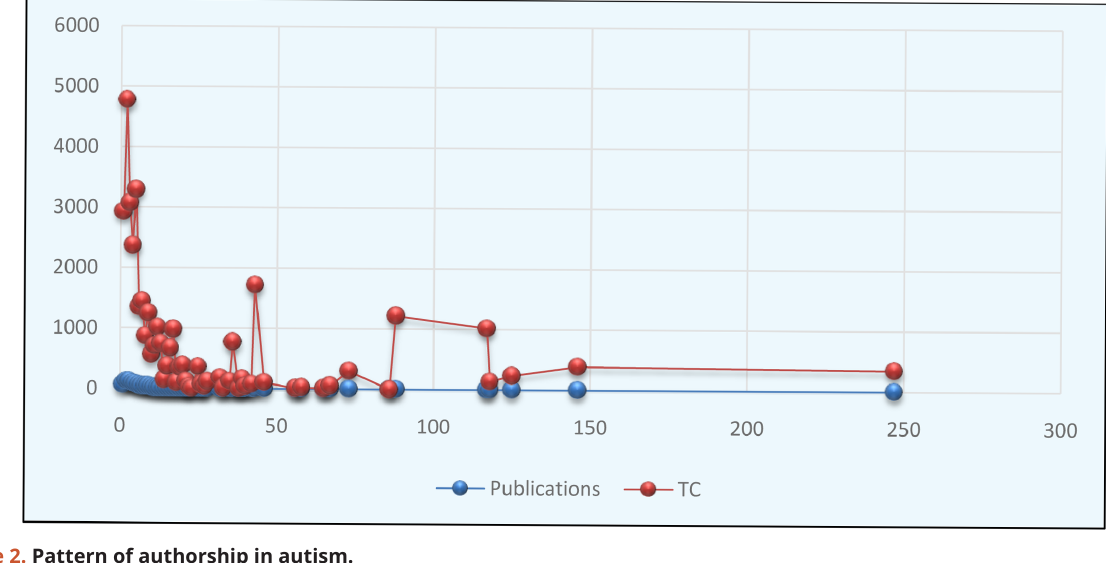
Figure 2. Pattern of authorship in autism.